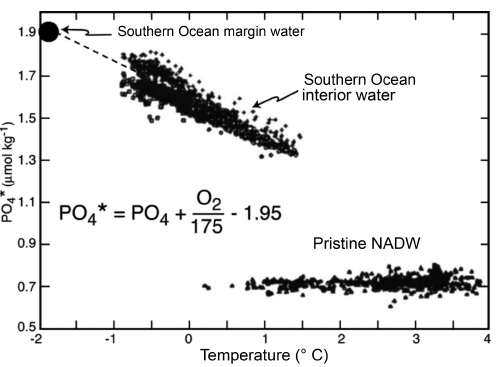
Figure 1. Plots of PO ∗ versus potential temperature for water 4 formed in the northern Atlantic and in the Southern Ocean (based on measurements made as part of the GEOSECS expeditions). Note that all contributors of NADW have PO ∗ values within the measure- 4 ment error of 0.75µmolkg − 1 . The Southern Ocean PO ∗ was orig- 4 inally obtained by extrapolating the observed PO ∗ – temperature 4 trend to sea water’s freezing point (Table 1). As shown in Figs. 3 and 4, this extrapolated value is consistent with values observed close to the Antarctic margin in the Weddell Sea.